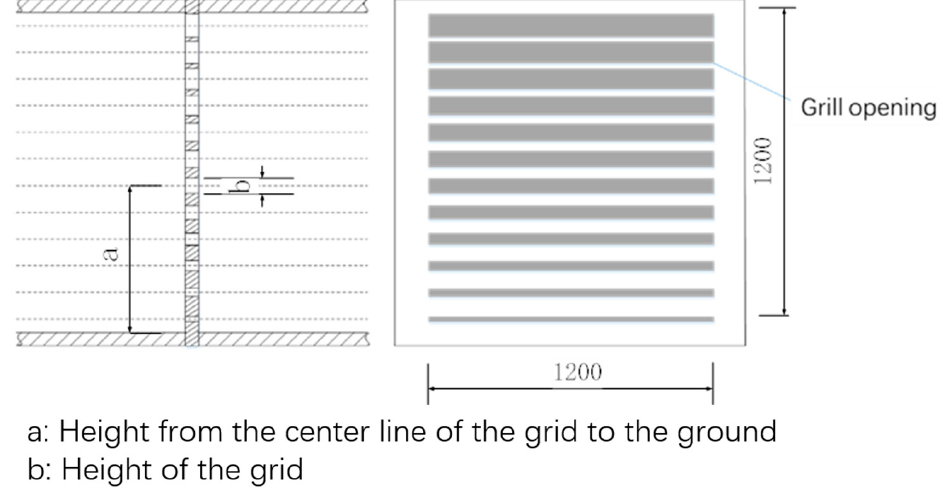
Figure 3. Schematic diagram of a grid plate with unequal spacing (unit: mm). Table 1. Dimensions of the grill openings of the grid